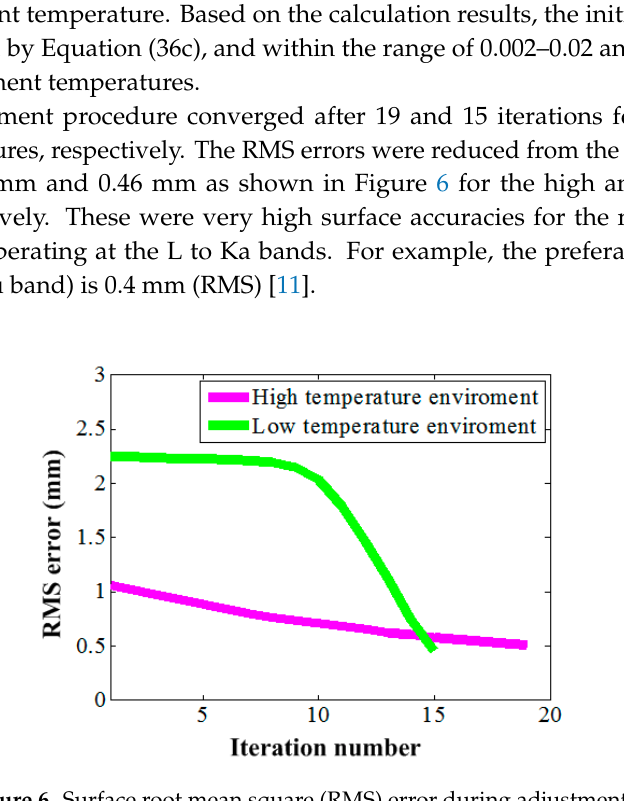
( d ) Figure 7. Element elongation under the control temperature: ( a ) Variations of all elements of vertical cables under environment temperature 140 °C, ( b ) single element change under environment temperature 140 °C, ( c ) variations of all elements of vertical cables under environment temperature − 100 °C and ( d ) single element change under environment temperature − 100 °C. Figure 8 gives the element stress change under the control temperature. For the high environment temperature, the rule of the adjustment magnitudes of the element stress of those adjustable SMA cable elements was similar to that of the element elongation change case, which showed a gradual increase from the elements of the central region to the outside ones from 12.1 MPa to 98.1 MPa, as shown in Figure 8a. However, for the low environment temperature, the adjustment magnitudes of the stress of those elements were identical completely as 83.7 MPa, as shown in Figure 8c. The stress adjustment of the selected element with node 80 presented a clear change at the